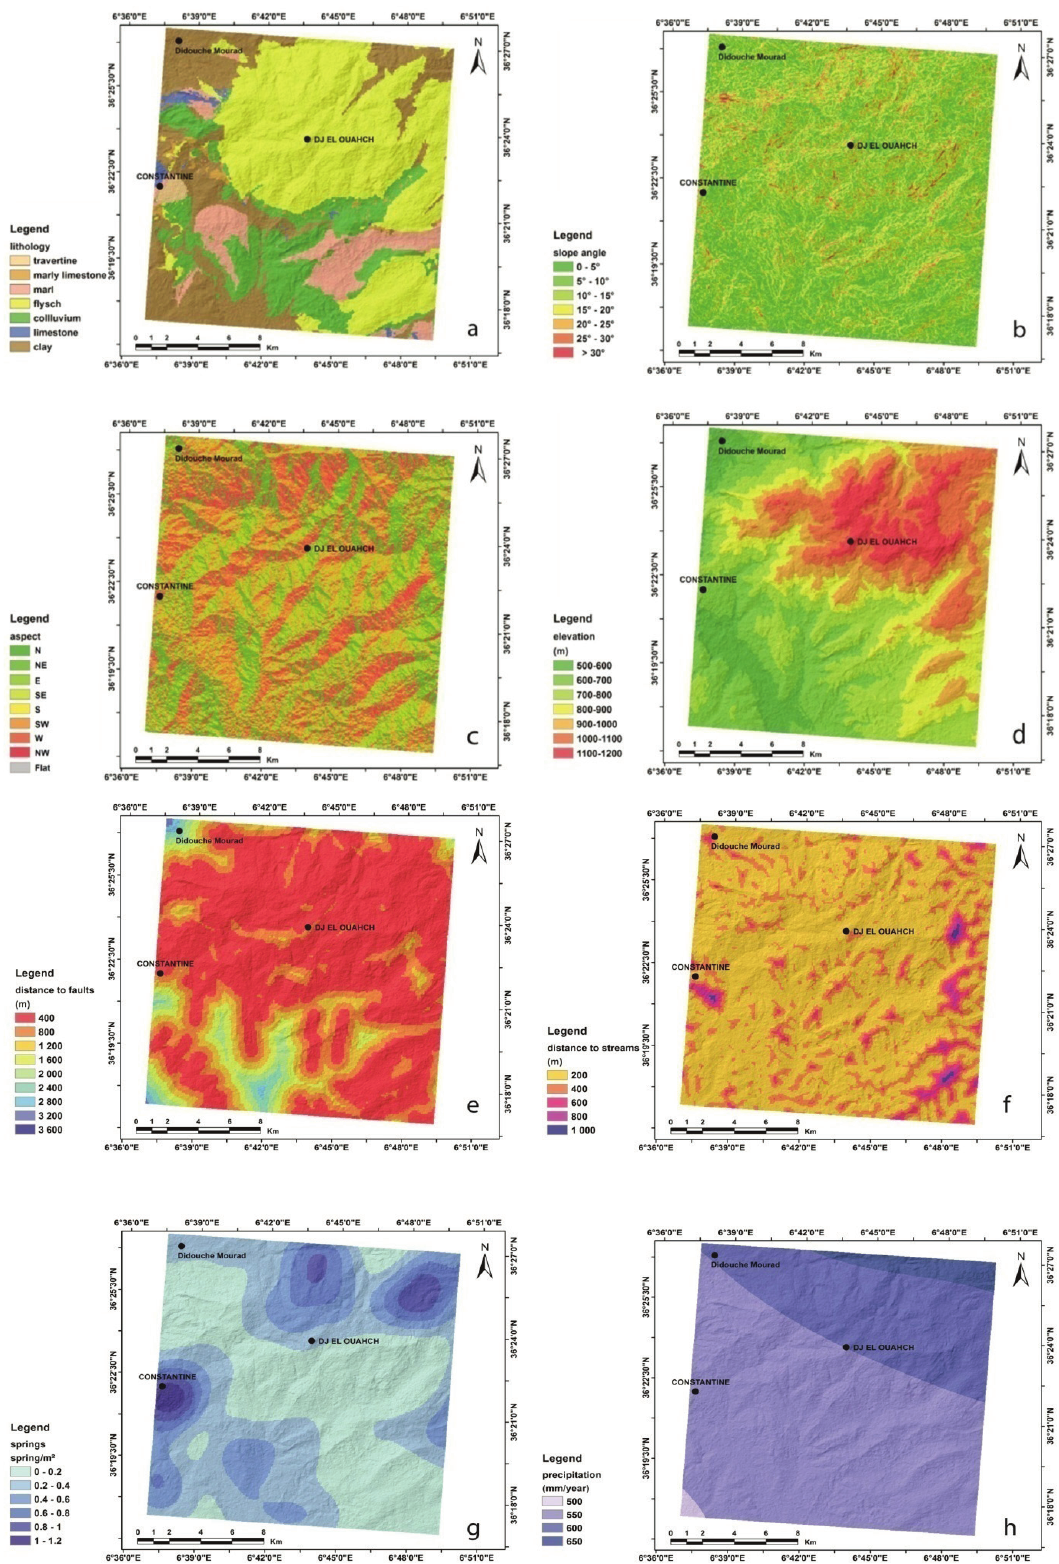
Figure 4: Landslide conditioning factor used for landslide susceptibility mapping in the study area: a- Lithology. b- Slope angle. c- Slope aspect. d-